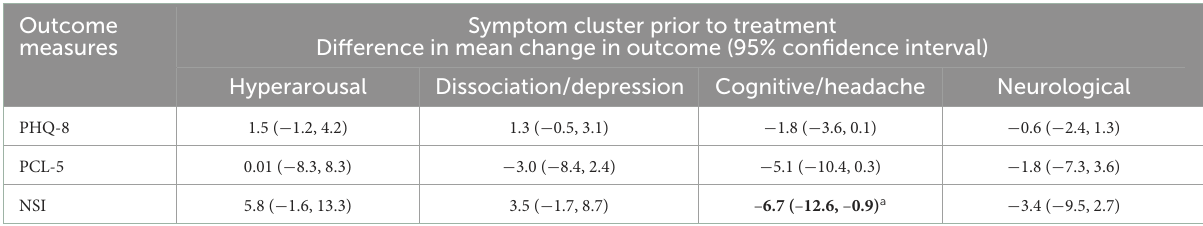
TABLE 2 Association between the level of symptom cluster (in z -score) prior to treatment and the rate of change in outcome ( n = 483). Outcome